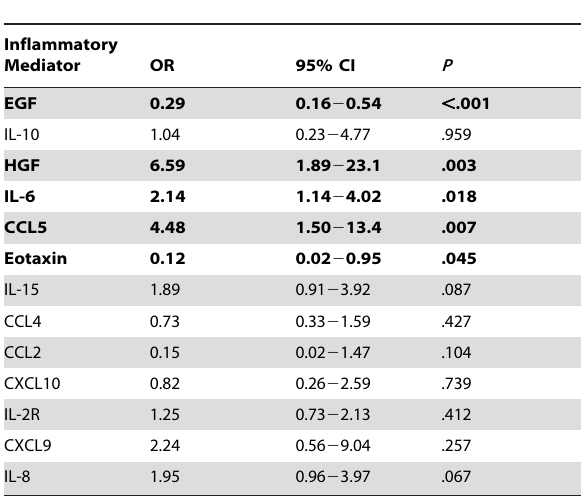
Table 4. Multiple logistic regression results for serum inflammatory mediators (cytokines, chemokines, and growth factors) in patients with Clostridium difficile infection (CDI) vs. outpatient asymptomatic controls who tested negative for CDI (all units in log - 10